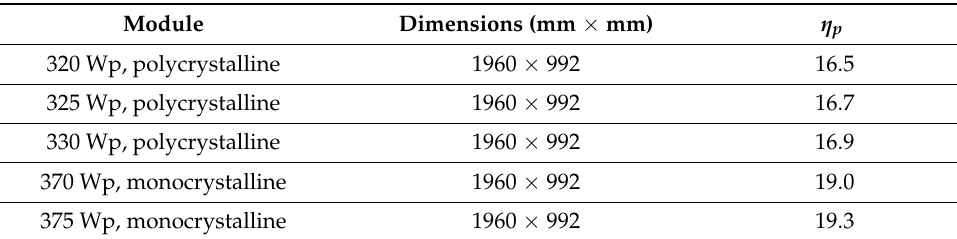
Table 6. Expected efficiency for different types of